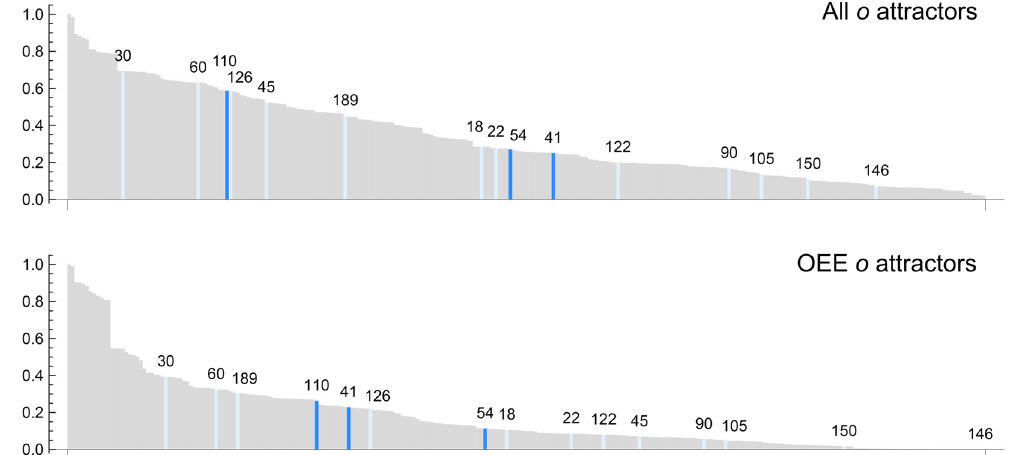
Figure 9. Rank ordered frequency distributions of rules implemented in the attractor dynamics of o for all sampled Case I CA (top) and OEE cases only (bottom). Highlighted are Wolfram Class III (light blue) and IV rules (dark